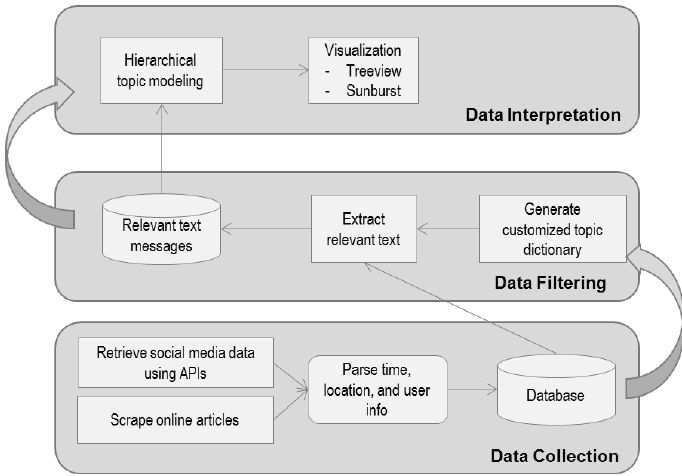
Figure 1. The workflow of collecting and analyzing social media data.